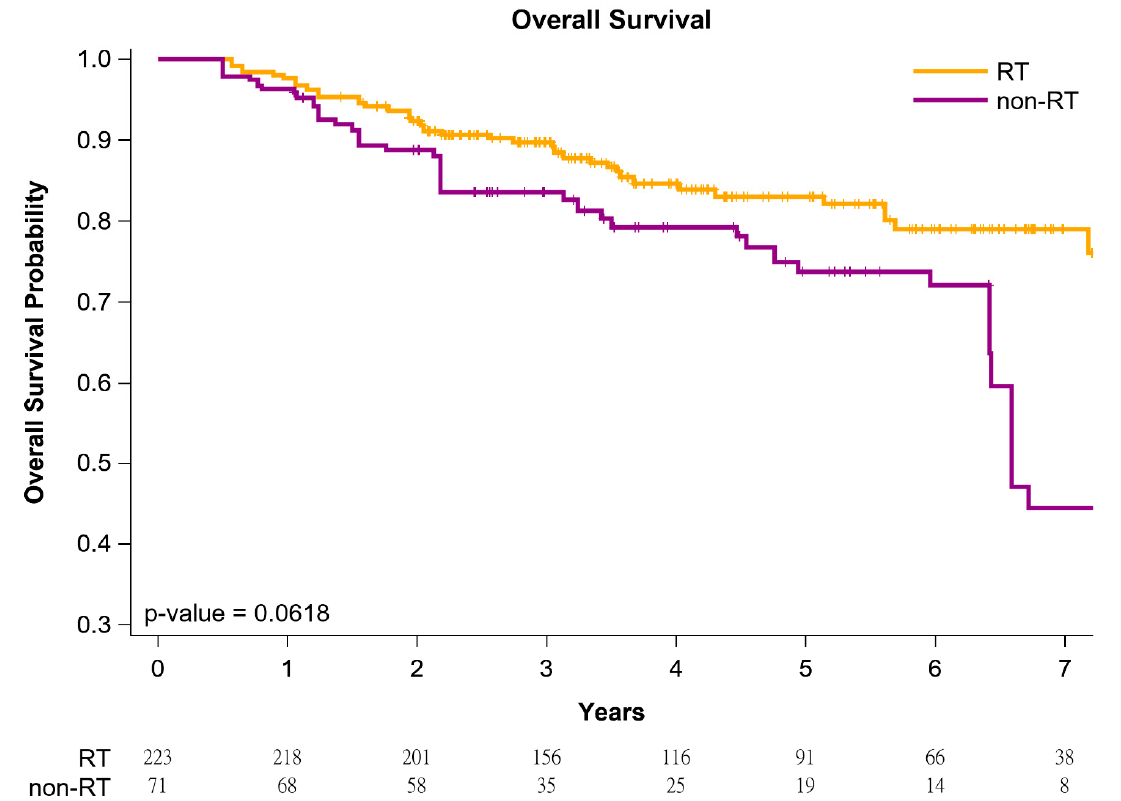
Figure 1. Kaplan–Meier overall survival curves of propensity score–weighted population with breast cancer and heart failure with reduced ejection fraction receiving breast conservative surgery.